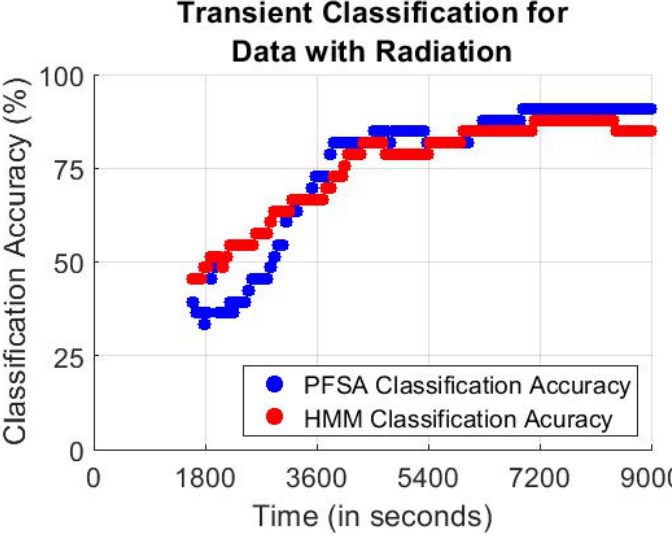
Figure 7. Transient classification accuracy over all datasets with radiation heat